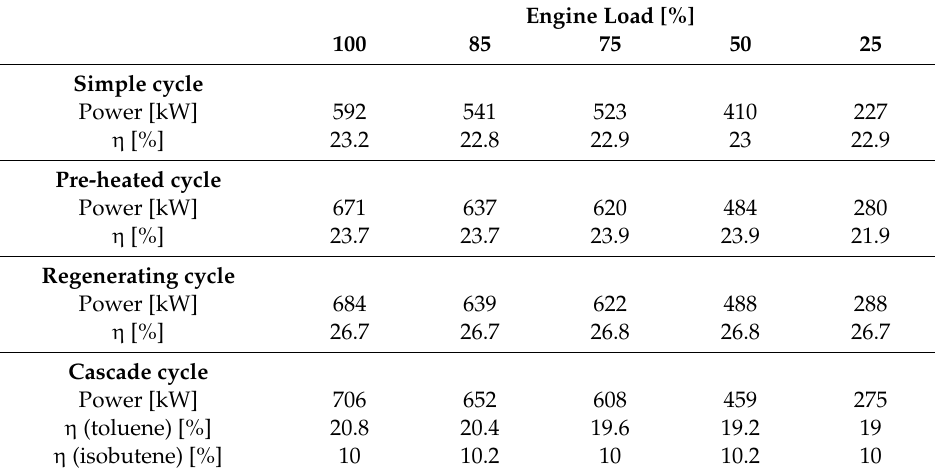
Table 3. Performance comparison of different configurations of the ORC bottom cycle.